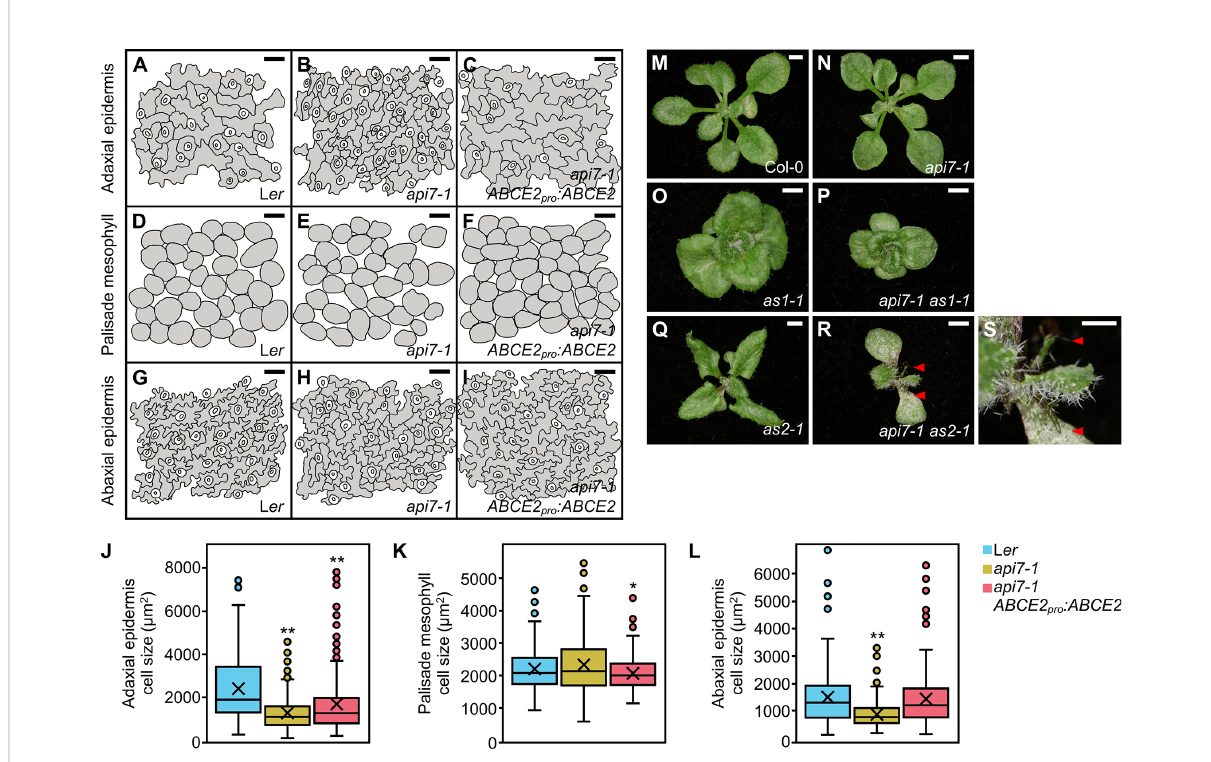
FIGURE 2 Dorsoventral patterning in api7-1 leaves. (A – L) Leaf cell phenotypes of L er , api7-1 , and api7-1 ABCE2 pro :ABCE2 plants. (A – I) Representative diagrams of the (A – C) adaxial epidermis, (D – F) subepidermal layer of palisade mesophyll, and (G – I) abaxial epidermis, from (A, D, J, G) L er , (B, E, H) api7-1 , and (C, F, I) api7-1 ABCE2 pro :ABCE2 plants. (J – L) Boxplot distributions of cell area in the (J) adaxial epidermis, (K) subepidermal layer of palisade mesophyll, and (L) abaxial epidermis, from fi rst-node leaves collected 21 das. Other details as described in the legend of Supplementary Figure S1 for its (A) section. Between 144 and 351 cells were analyzed from at least 4 different samples. Asterisks indicate a signi fi cant difference with the L er wild-type in a Student ’ s t test (* P < 0.05, ** P < 0.001). (M – S) Genetic interactions of api7-1 with as1-1 and as2-1 . Rosettes from the wild-type (M) L er , the (N) api7-1 , (O) as1-1 , and (Q) as2-1 single mutants, and the (P) api7-1 as1-1 and (R) api7-1 as2-1 double mutants. (G) Close up of (F) . Red arrowheads indicate radial leaves. Pictures were taken 16 das. Scale bars indicate (M – R) 2 and (S) 1